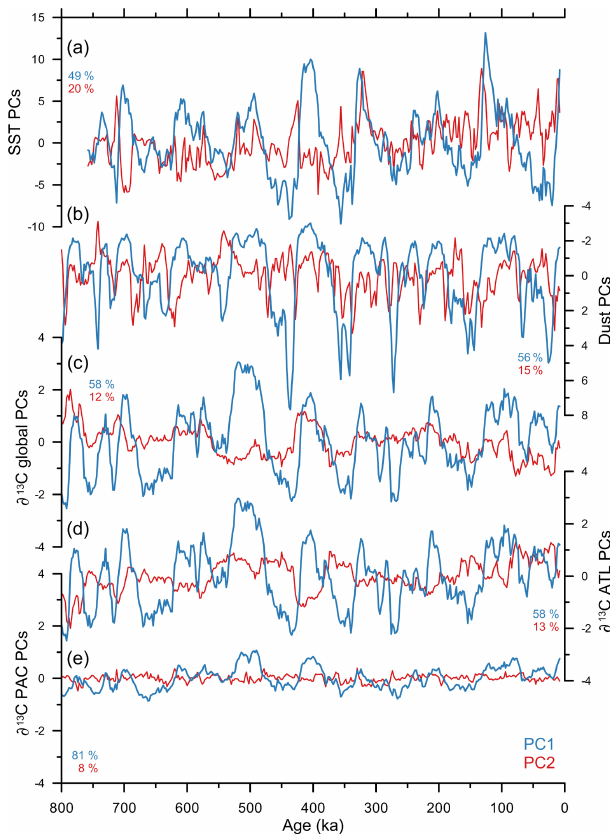
Figure 3. Principal components. Plots of the first (PC1; blue) and second (PC2; red) principal components from our EOF analysis of each climate variable. Percent variance is explained by each PC represented by the numbers with the corresponding color. (a) Sea- surface temperatures. (b) Dust records. (c) Global ∂ 13 C. (d) ∂ 13 C of the Atlantic. (e) ∂ 13 C of the